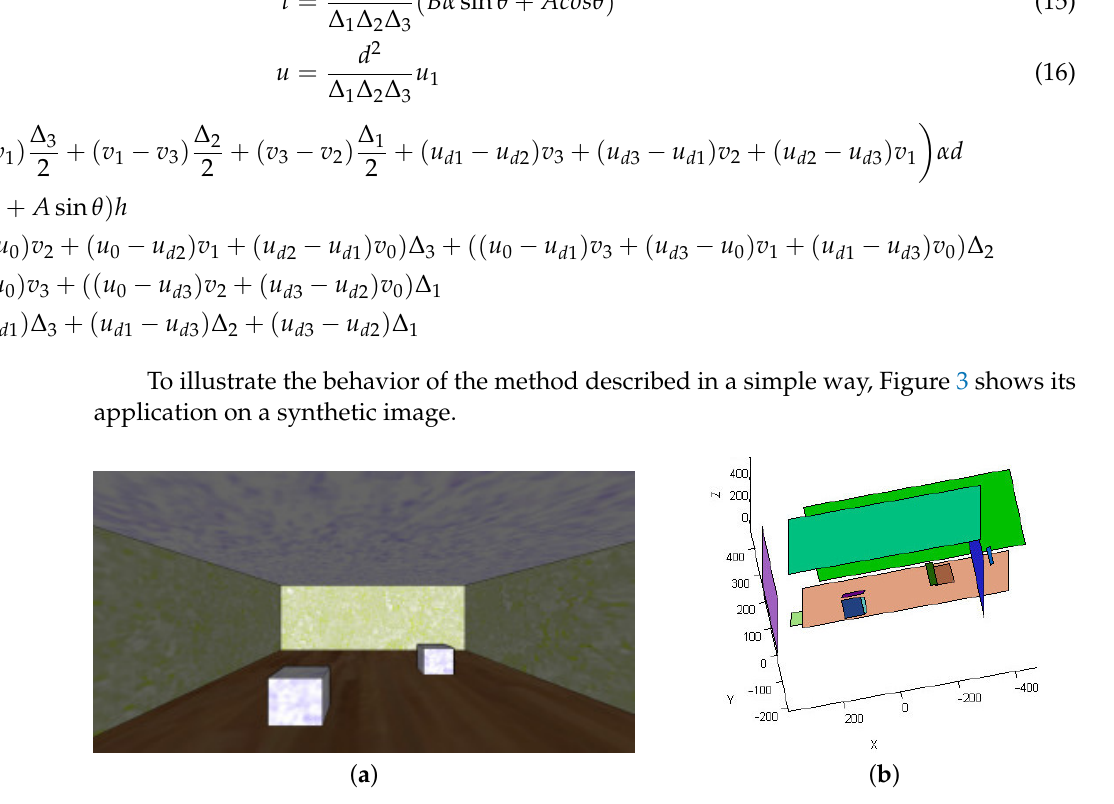
Figure 3. ( a ) Synthetic test scene; ( b ) reconstruction obtained from ( a